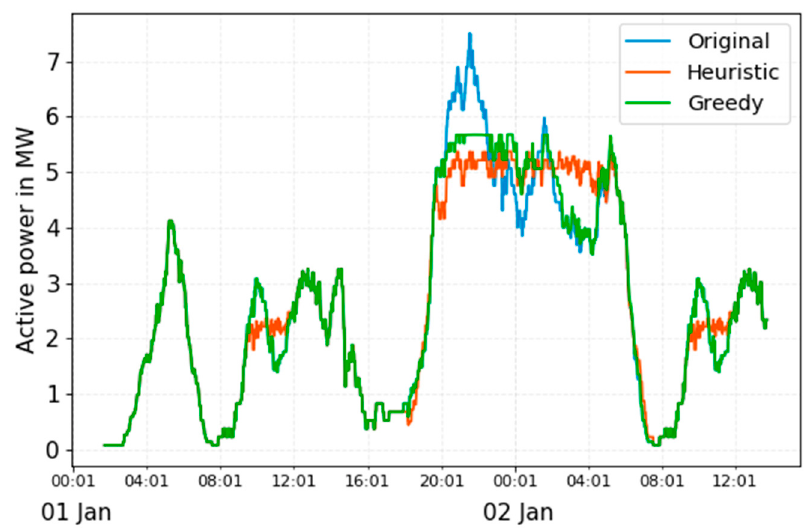
Figure 9. Load profiles resulting from the original, greedy, and heuristic schedule.